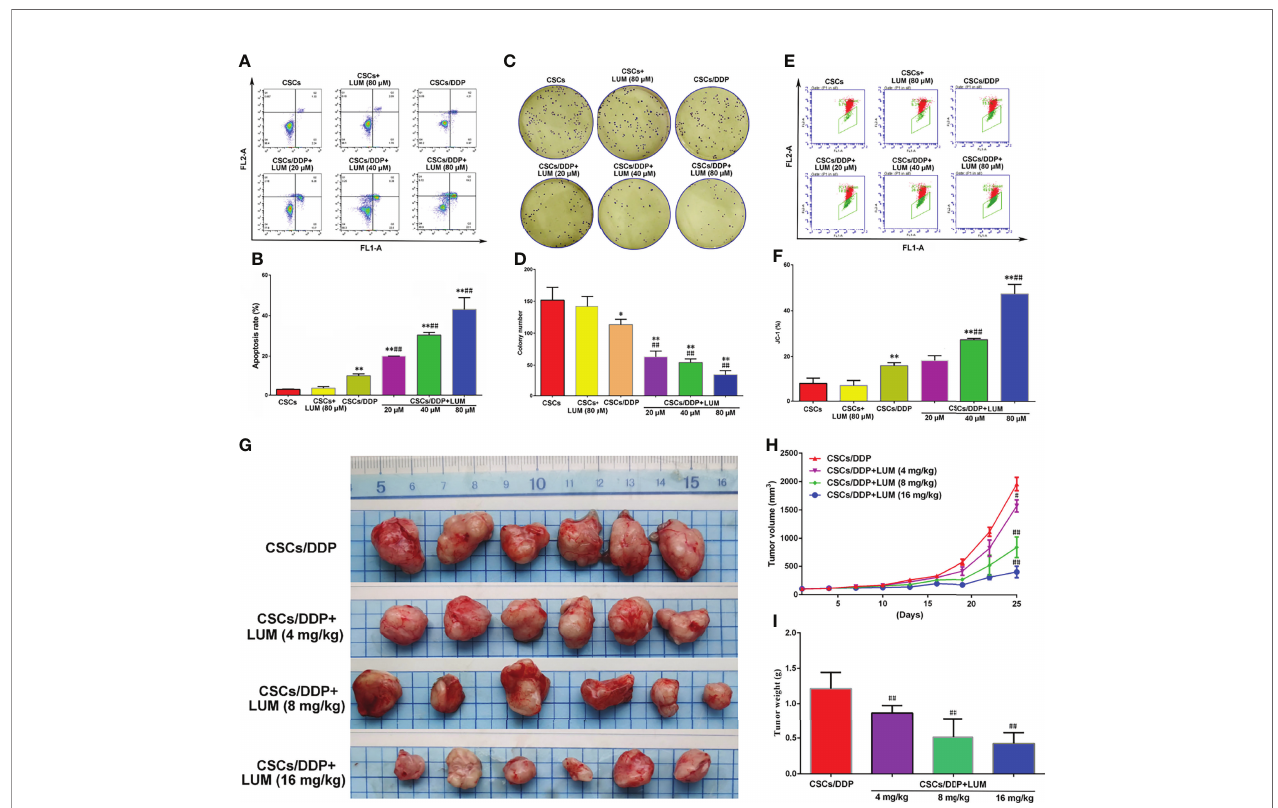
FIGURE 3 | Lumi fl avin enhances the chemotherapy effect of DDP on DDP-resistant cancer stem cells (CSCs/DDP). CSCs, CSCs/DDP were treated with 80 m M DDP, and CSCs/DDP were treated with 80 m M DDP and 20, 40, 80 m M lumi fl avin for 72 h. Apoptosis and clone formation ability were detected. Moreover cell mitochondrial membrane potential were tested by JC-1 prob (27, 28). CSCs/DDP were subcutaneously inoculated in nude mice and treated with DDP (DDP 5 mg/kg, once a week) combined with lumi fl avin for 25 d. Tumor weight and inhibited tumor growth curve were measured. (A) Flow cytometry of cell apoptosis as detected using Annexin V-FITC. (B) Statistical analysis graph of (A, C) Images of colony formation assay. (D) Statistical analysis graph of (C, E) Flow cytometry scatter plot of the potential of the mitochondrial membrane ( Dy m) of cells as detected through fl ow cytometry by using a JC ‐ 1 probe. (F) Statistical analysis graph of (E) . (G) Photograph of tumors. (H) Tumor growth curve of nude mice. (I) Statistical graph of tumor weight. Mean ± SD ( n = 3, cells; n = 6, mice). * P < 0.05 compared with the CSC group; ** P < 0.01 compared with the CSC group; ## P < 0.01 compared with CSC/DDP group. CSCs, CSCs from OVCAR-3 cell lines; CSCs/DDP, CSCs from DDP resistant OVCAR-3 cell lines; LUM, lumi fl